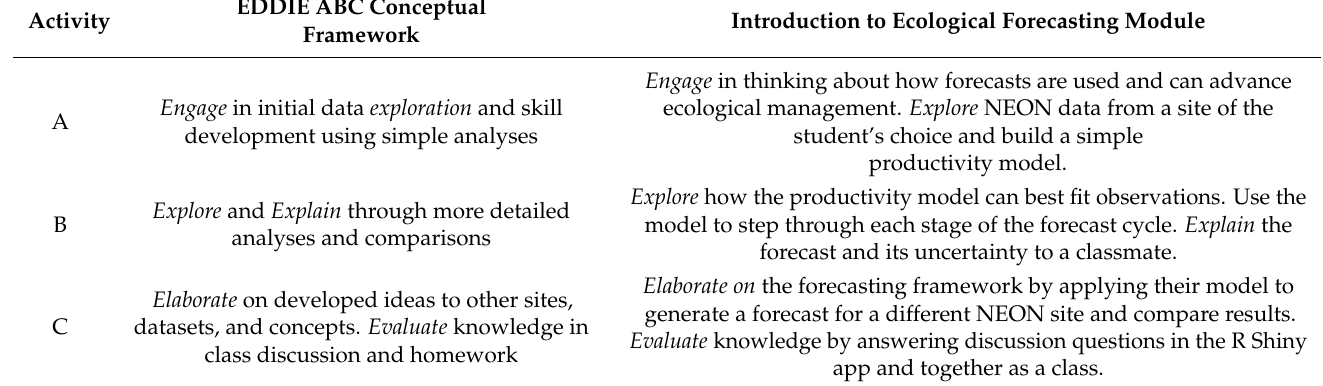
Table 1. Overview of the conceptual structure of all EDDIE modules adapted from the authors of ref.[37] and scaffolding of the Introduction to Ecological Forecasting module with a summary of the ABC activities within the module. See ref.[35] for more information and module teaching materials. The module applies the 5E instructional model, with the 5Es (Engagement, Exploration, Explanation, Elaboration, Evaluation) italicized